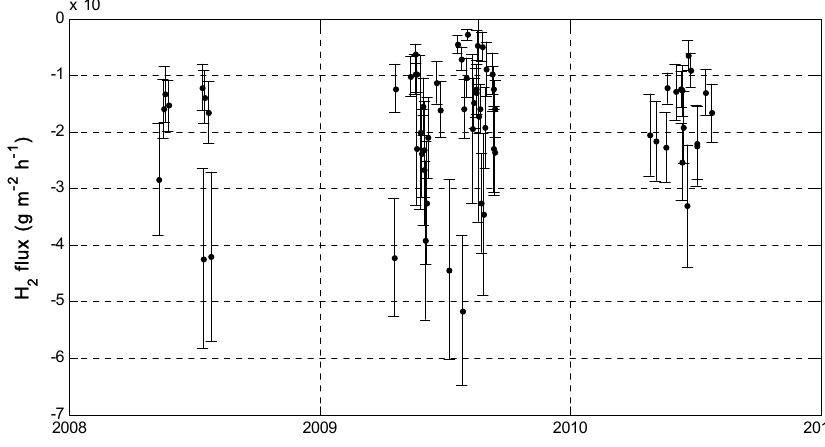
Fig. 8. H 2 soil deposition flux calculated with the 222 Rn tracer method for selected deposition events.